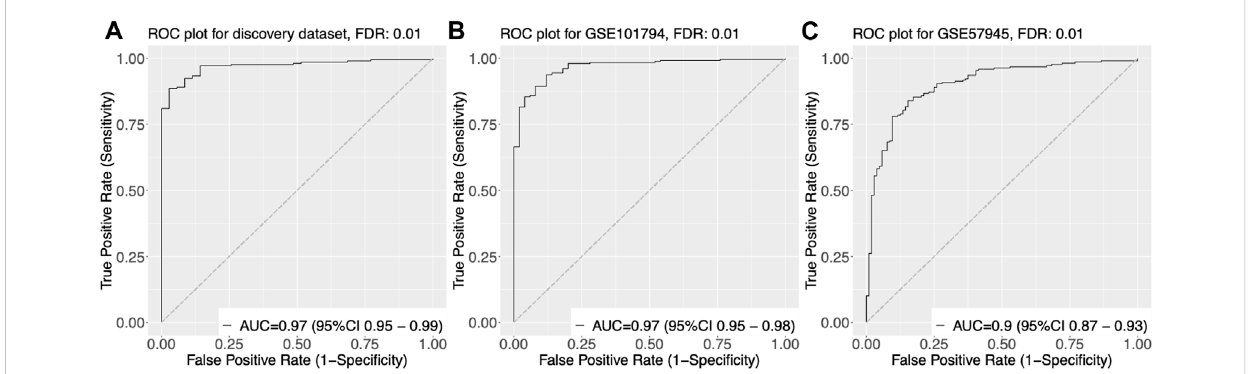
FIGURE 3 Receiver Operating Characteristic (ROC) curves of gene expression-based classi fi cation of Pediatric Crohn ’ s Disease in three datasets. (A) ROC curve of GSE101794 dataset, showing the relationship between the true positive rate (sensitivity) and false positive rate (1-speci fi city) for different threshold values of gene expression levels for Pediatric Crohn ’ s Disease classi fi cation. The area under the curve (AUC) is indicated. (B) ROC curve of GSE57945 dataset, showing the relationship between the true positive rate (sensitivity) and false positive rate (1-speci fi city) for different threshold values of gene expression levels for Pediatric Crohn ’ s Disease classi fi cation. The area under the curve (AUC) is indicated. (C) ROC curve of GSE93624 dataset, showing the relationship between the true positive rate (sensitivity) and false positive rate (1-speci fi city) for different threshold values of gene expression levels for Pediatric Crohn ’ s Disease classi fi cation. The area under the curve (AUC) is indicated.